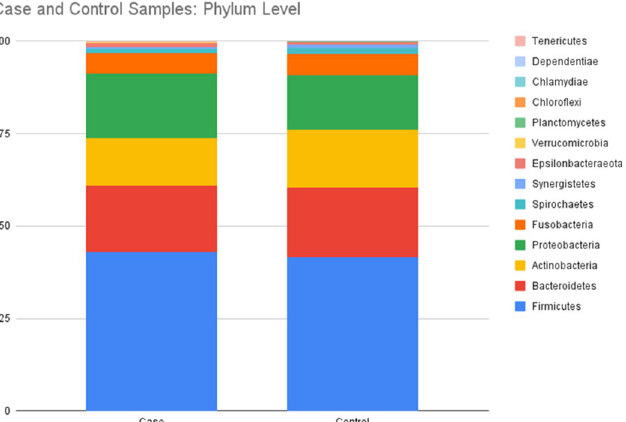
Fig 1. Relative abundance of dominant phyla in bile from patients with benign (control) and malignant (case) pancreaticobiliary diseases.